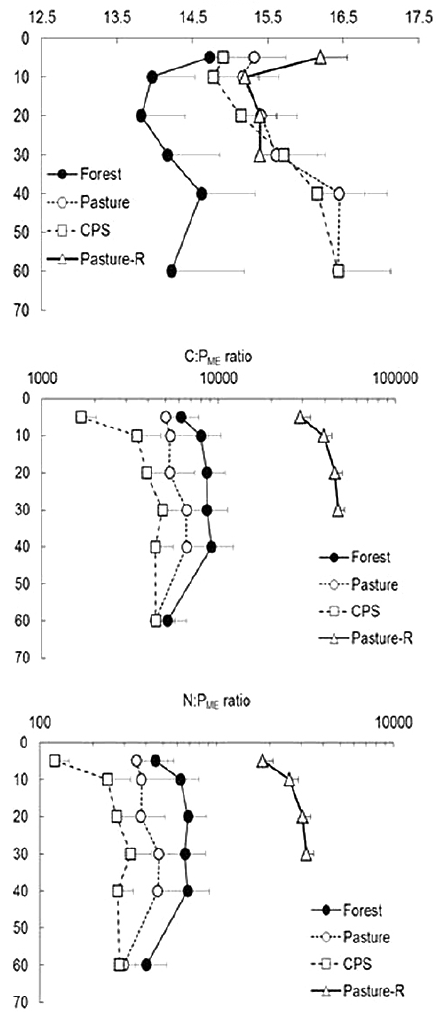
Figure 3. Soil depth variability of (a) C:N ratios, (b) C:P ME and (c) N:P ME in forest, pasture and CPS soils of the paired study sites and of the regional pasture survey (Pasture-R). Points represent the means by soil depth and the horizontal bars are standard